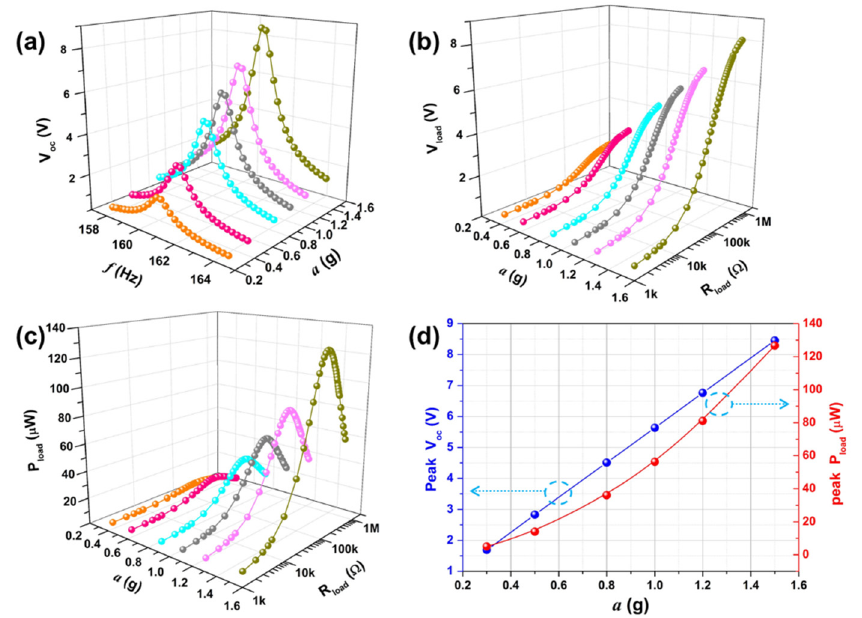
Figure 8. The output performance of the MEMS TCB based PVEH prototype under different accel- erations, ( a ) open-circuit voltage of the device under different excitation frequencies and excitation accelerations, ( b ) load voltage of the device under different excitation acceleration and load re- sistance, ( c ) load power of the device under different excitation acceleration and load resistance, ( d ) variations of the peak open-circuit voltage and the peak load power of the device under different excitation acceleration.